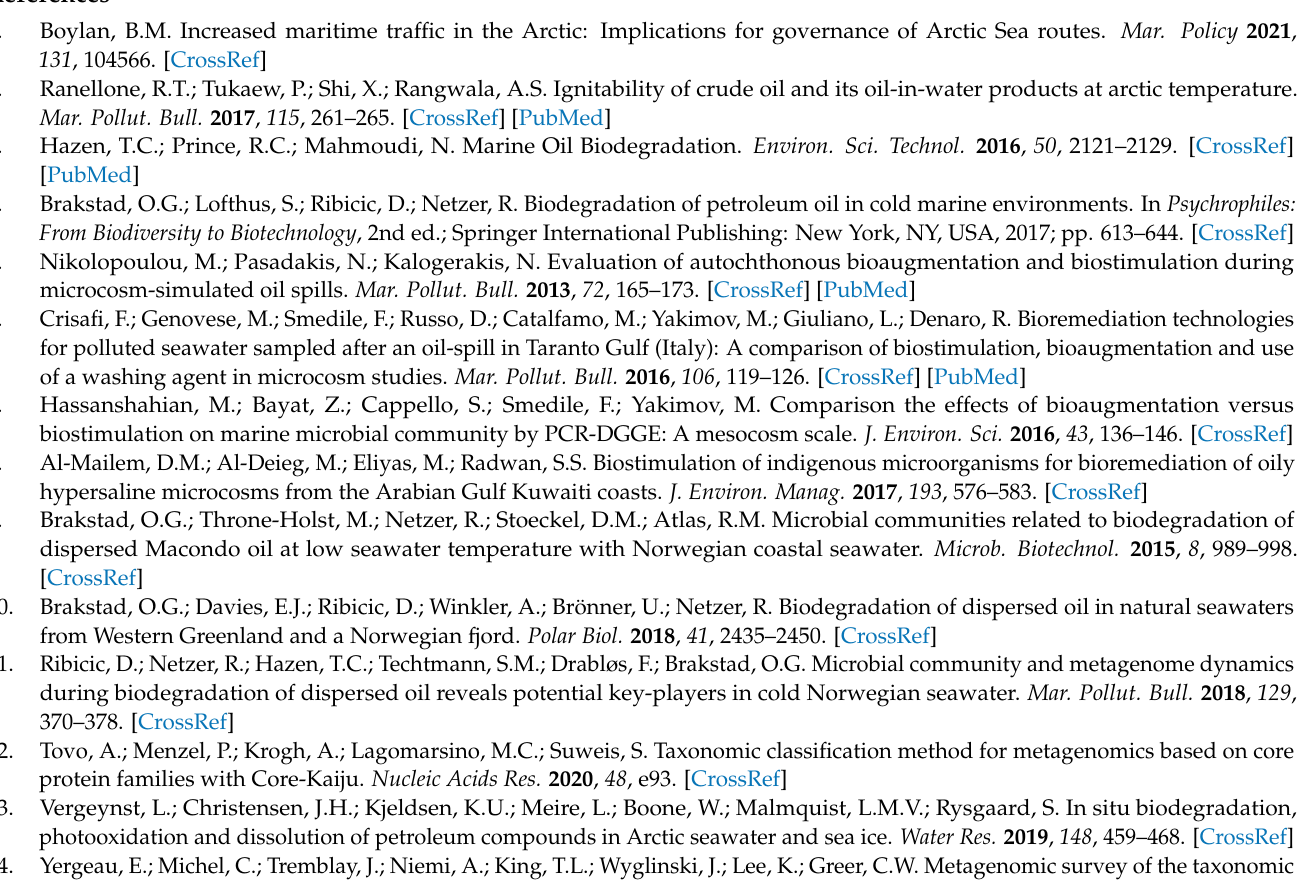
( E ) taxonomic classifications; Figure S4: Multiple co-inertia analysis results based on datasets of the top 50 bacterial genera proportions based on five taxonomic classification methods; Figure S5: Multiple co-inertia analysis results based on datasets of proportions of bacterial genera containing oil hydrocarbon degraders based on five taxonomic classification methods; Figure S6: The bacterial community structure at phylum, genus (>3%), and species (>3%) level in SW, SWO, and SWOB; Figure S7: The proportions of archaeal phyla as well as the most dominant archaeal genera and species in the archaeal community in SW, SWO, and SWOB; Section S1: Prokaryotic community structure in different treatments according to